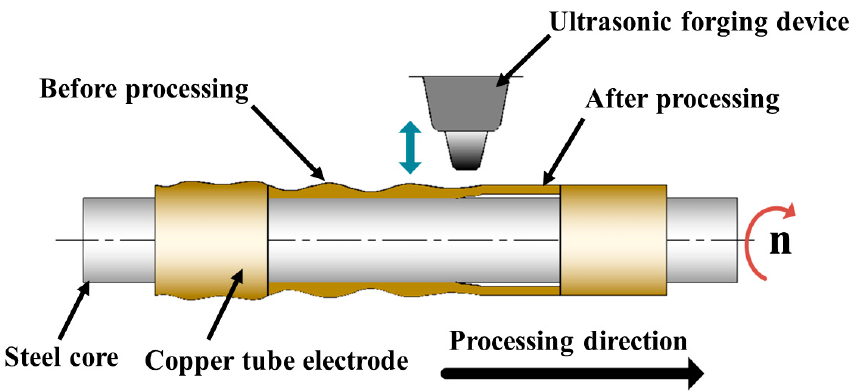
Figure 5. Ultrasonic high-frequency percussion fabrication of the processing mechanism for ultra-fine and ultra-long copper tube electrode.